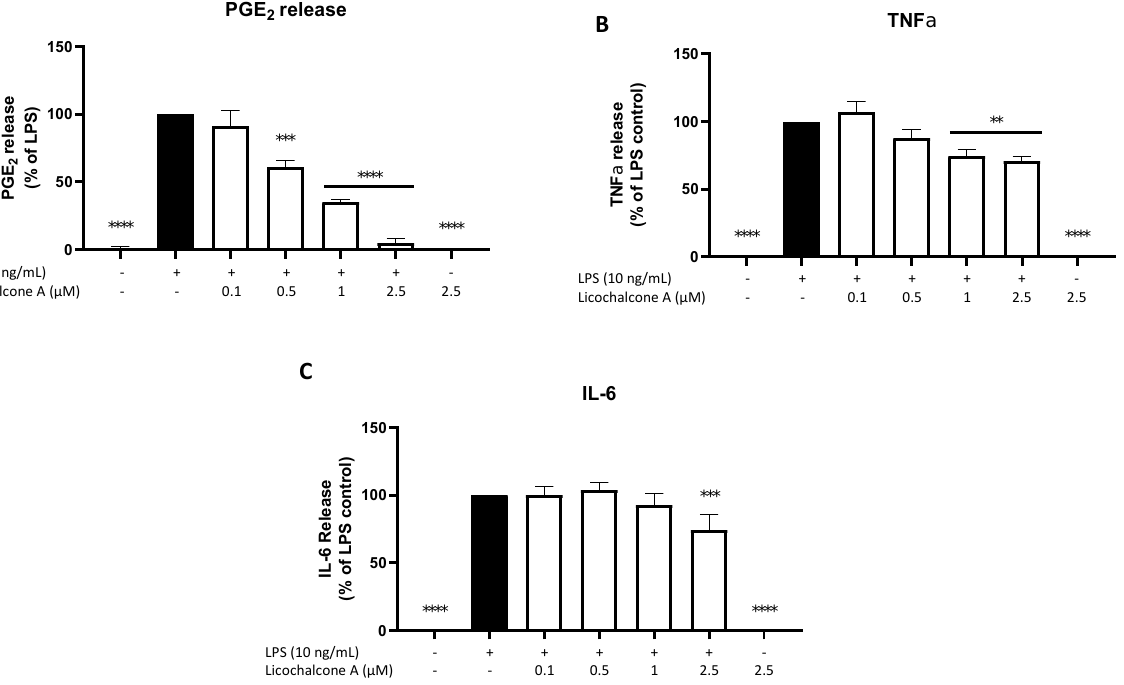
Figure 2. Effects of Licochalcone A on PGE 2 ( A ), TNF α ( B ), and IL-6 ( C ) release in LPS-stimulated primary rat microglial cells. Cells were stimulated as described under materials and methods and supernatants were collected for EIA/ELISA measurements after 24 h. Values are presented as the mean ± SEM of at least three independent experiments. Statistical analysis was performed using one-way ANOVA with Dunnett’s post hoc tests with ** p < 0.01, *** p < 0.001, and **** p < 0.0001 compared to LPS-stimulated cells.